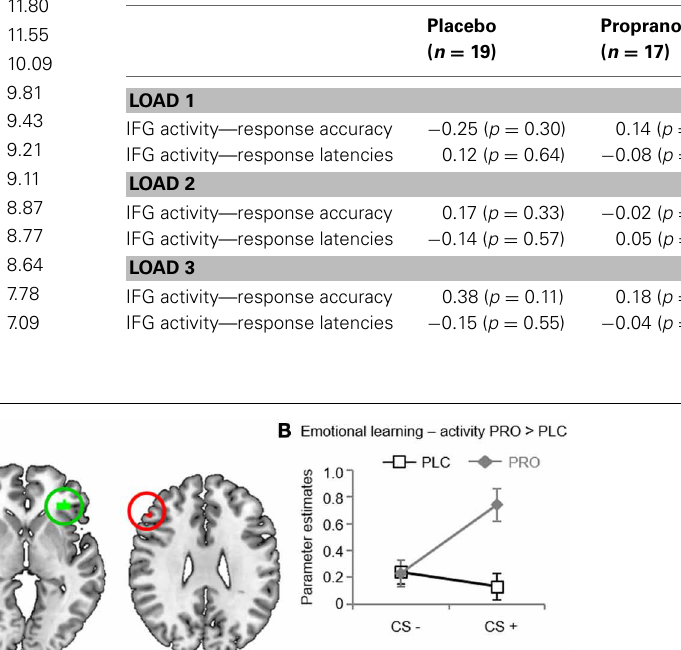
estimates from the left inferior frontal gyrus and working memory performance.